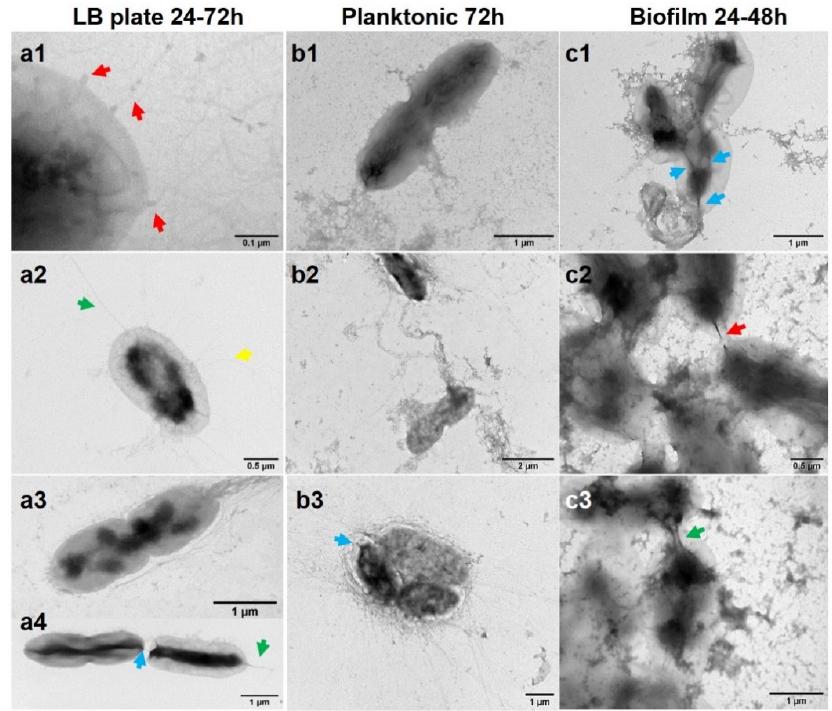
Figure 5. TEM analysis of cellular feature of CITA 33 cells in LB medium. On petri plate in static conditions at 24 h ( a1 ) and 72 h ( a2 – a4 ) growth. Planktonic cells in liquid culture at 72 h ( b1 – b3 ) growth. 24 h ( c1 ) and 48 h ( c2 , c3 ) mature biofilm.